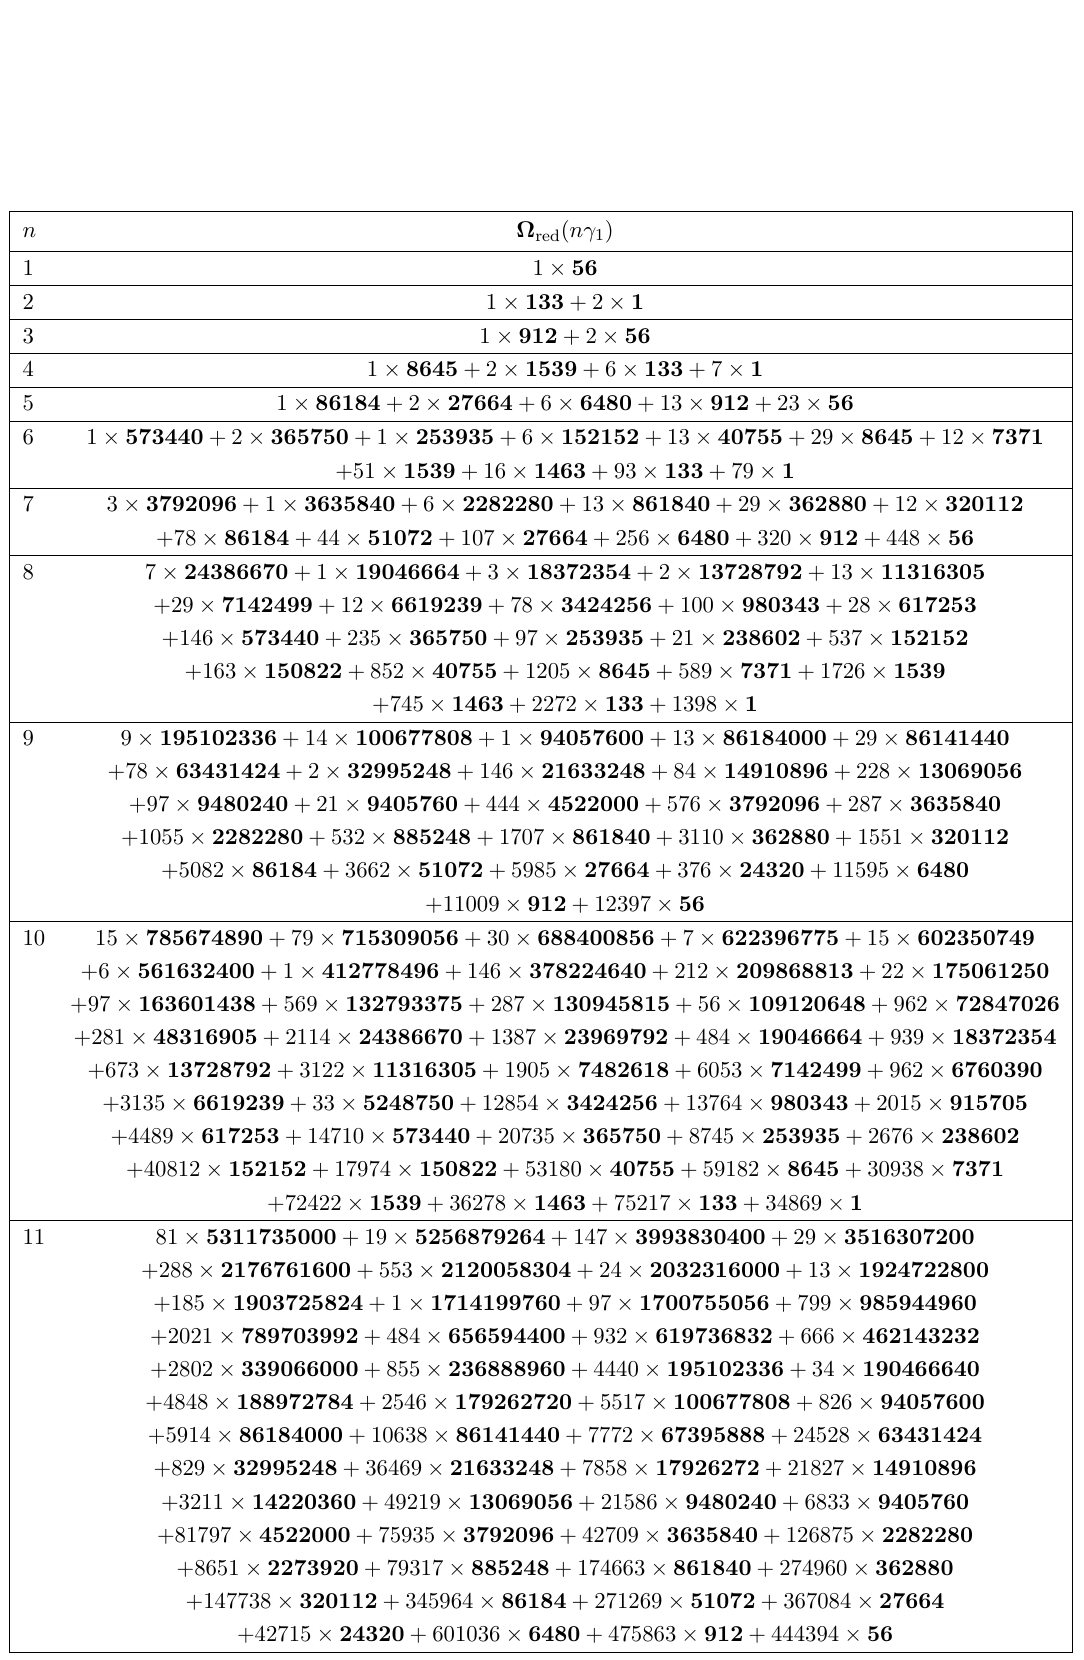
Table 1 . Reduced indices for charges n(cid:13) 1 in the E 7 Minahan-Nemeschansky theory, with (cid:13)avor information